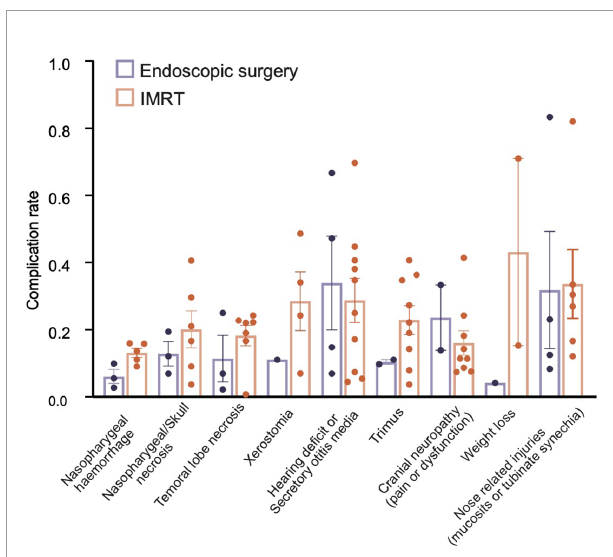
FIGURE 5 | Comparison of the combined incidence of major complications of endoscopic surgery and IMRT.